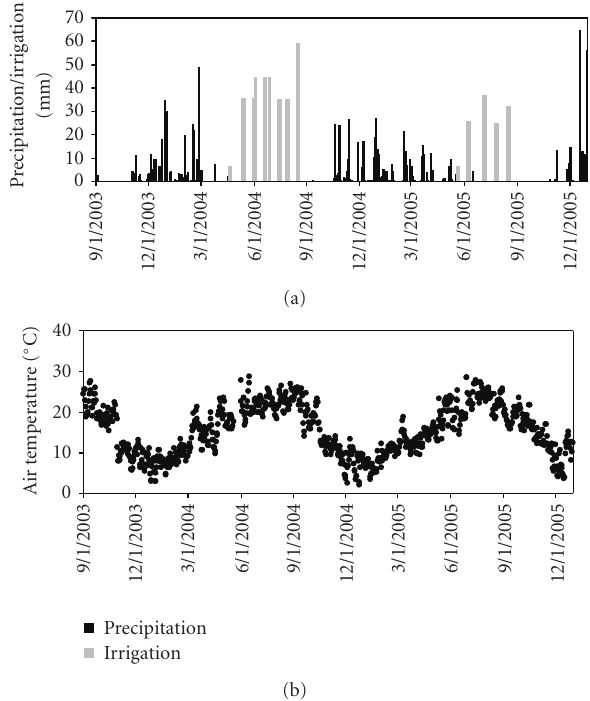
Figure 1: Precipitation, irrigation, and daily mean air temperature at the field site, September 2003–December